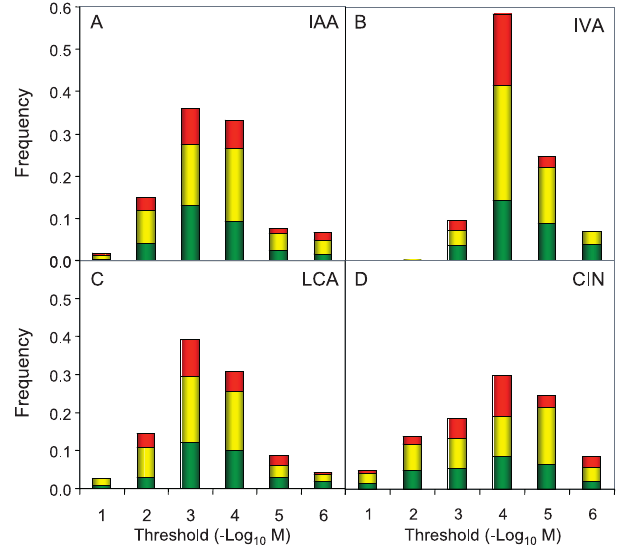
Figure 1. Olfactory Threshold Distributions Histograms of the measured olfactory thresholds for four odorants: IAA (A), IVA (B), LCA (C), and CIN (D). Odorants are expressed in molar (M) concentrations (in the oil solution) and were tested in 377 genotyped individuals, except CIN, which was tested in a randomly selected subsample of 200 participants. The data are presented for both genders pooled together. A threshold score of one indicates individuals who could not detect the highest possible odorant concentration (10 (cid:2) 2 M). Red, yellow, and green, respectively, represent fractions out of the